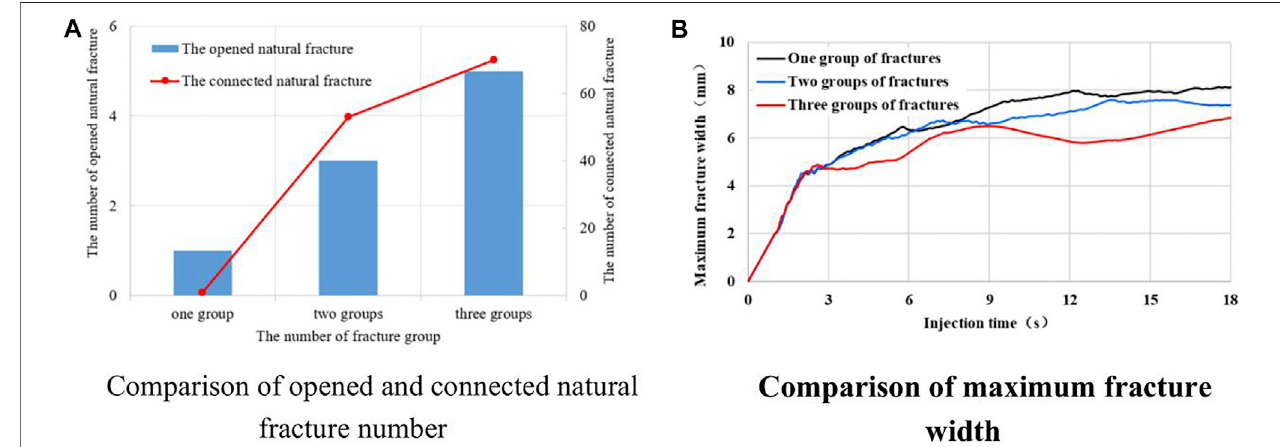
FIGURE 10 | The fracture morphology comparison of different natural fracture group. (A) Comparison of opened and connected natural fracture number. (B) Comparison of maximum fracture width.